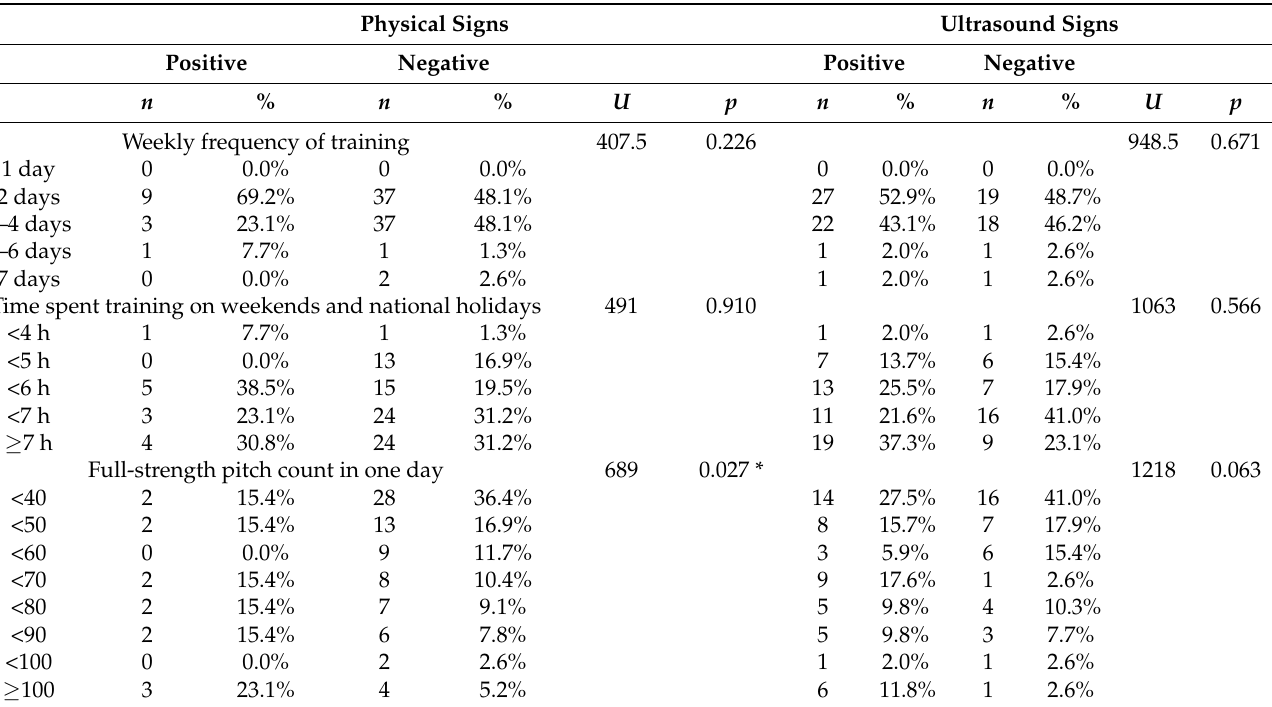
Table 2. Numbers and percentages of participants with signs of injury (frequency of training, duration of training, pitch